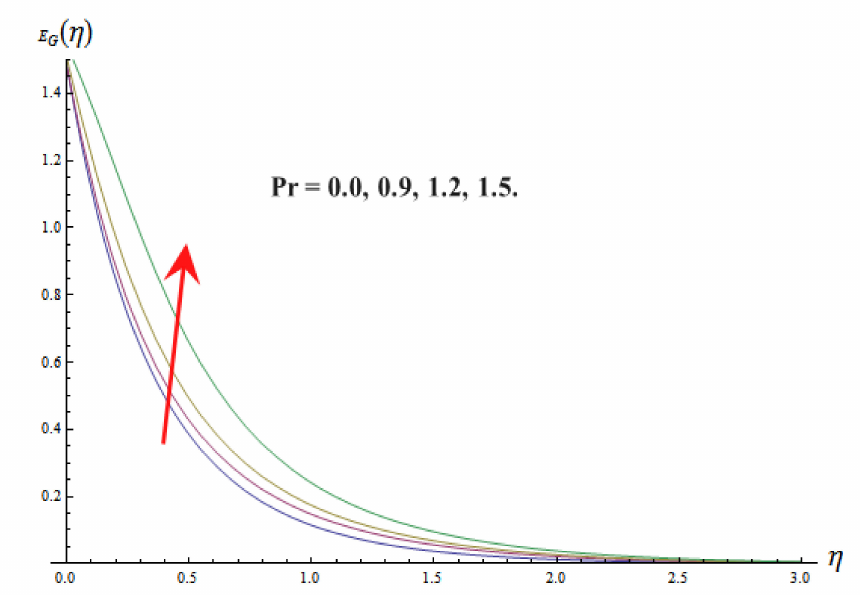
Figure 13. Impact of Pr on E G ( η ) keeping Γ = 0.5, Ha = 0.2, Br = 2, λ = 2, Ec = 0.2, Rd = 2, β 1 = 0.2, λ 1 = 0.2, K ∗ = 2.